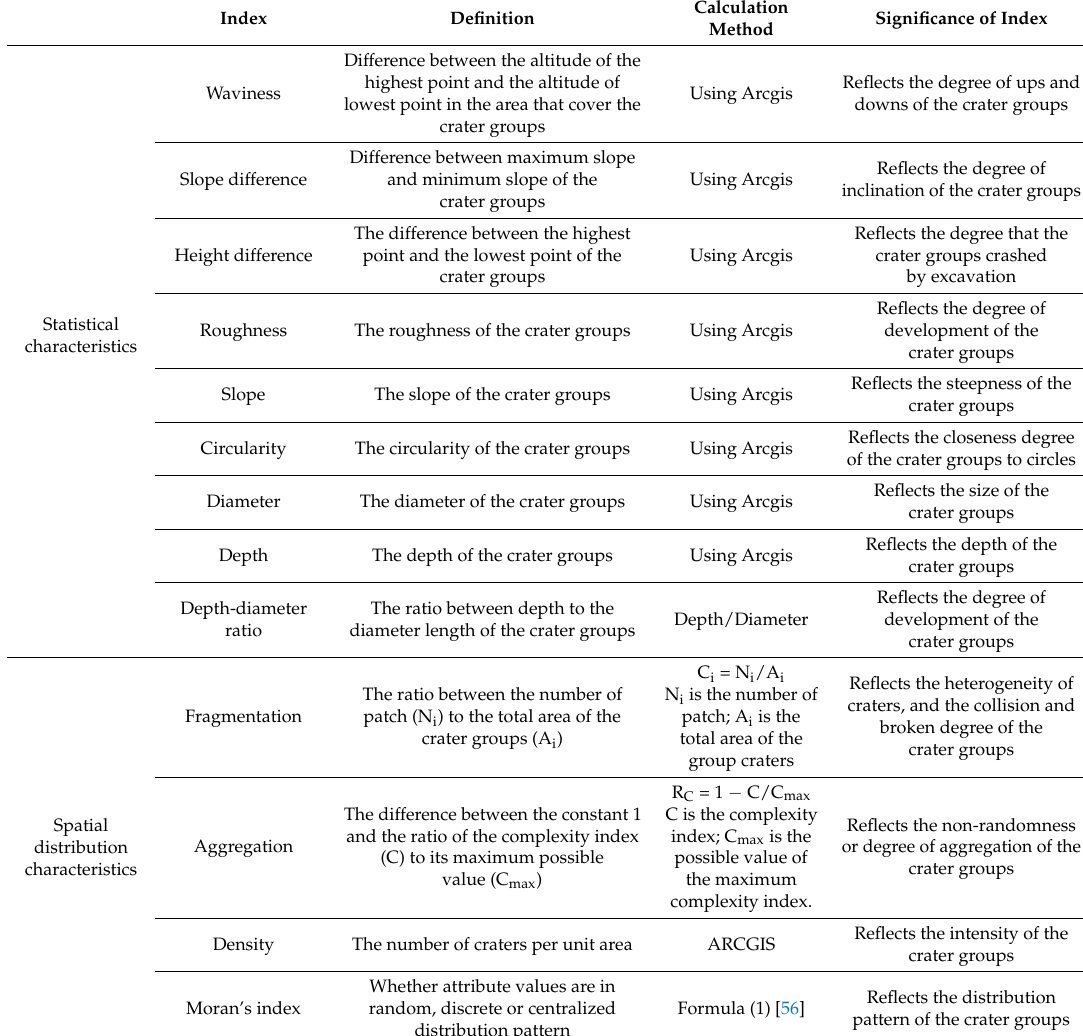
Table 7. Indices for description of crater groups (indices in red can be separated into eight sub-indices, see Section